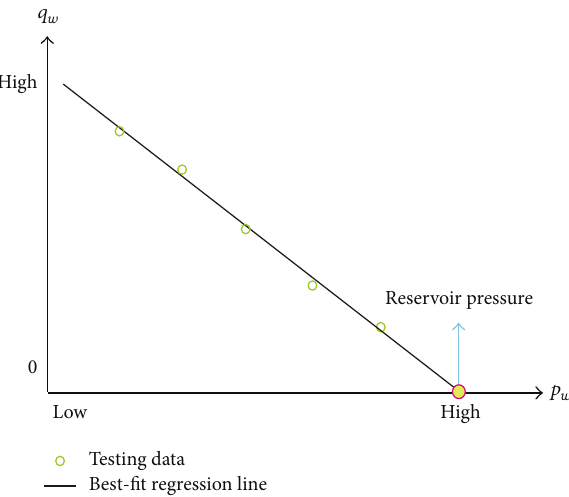
Figure 4: Reservoir pore pressure test by introducing fluctuation at the bottom hole